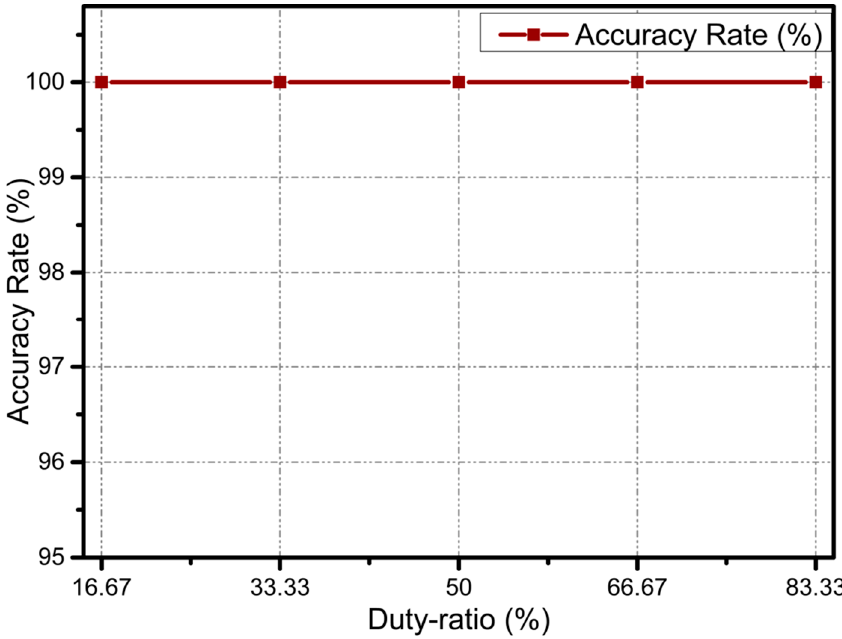
Figure 11. The recognition accuracy rate at different duty ratios.